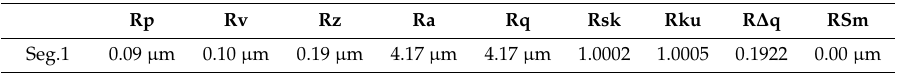
Figure 5. Appearance of a CSPA with a period of 25 μ m. ( a ) Two-dimensional topography and ( b ) three-dimensional topography and both the surface profiles indicating the height or depth by ( c ) and the featured horizontal size by ( d ). Table 2. Roughness related parameter